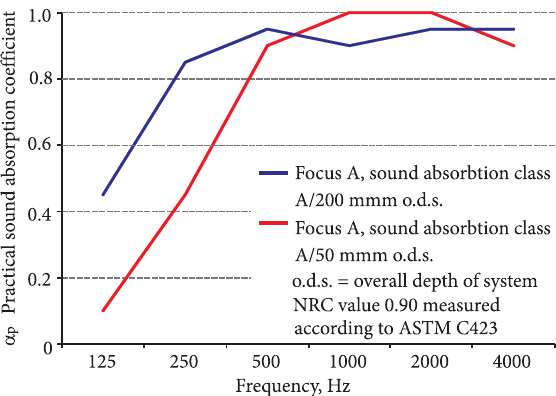
Fig. 8. Acoustic performance of the acoustic foam